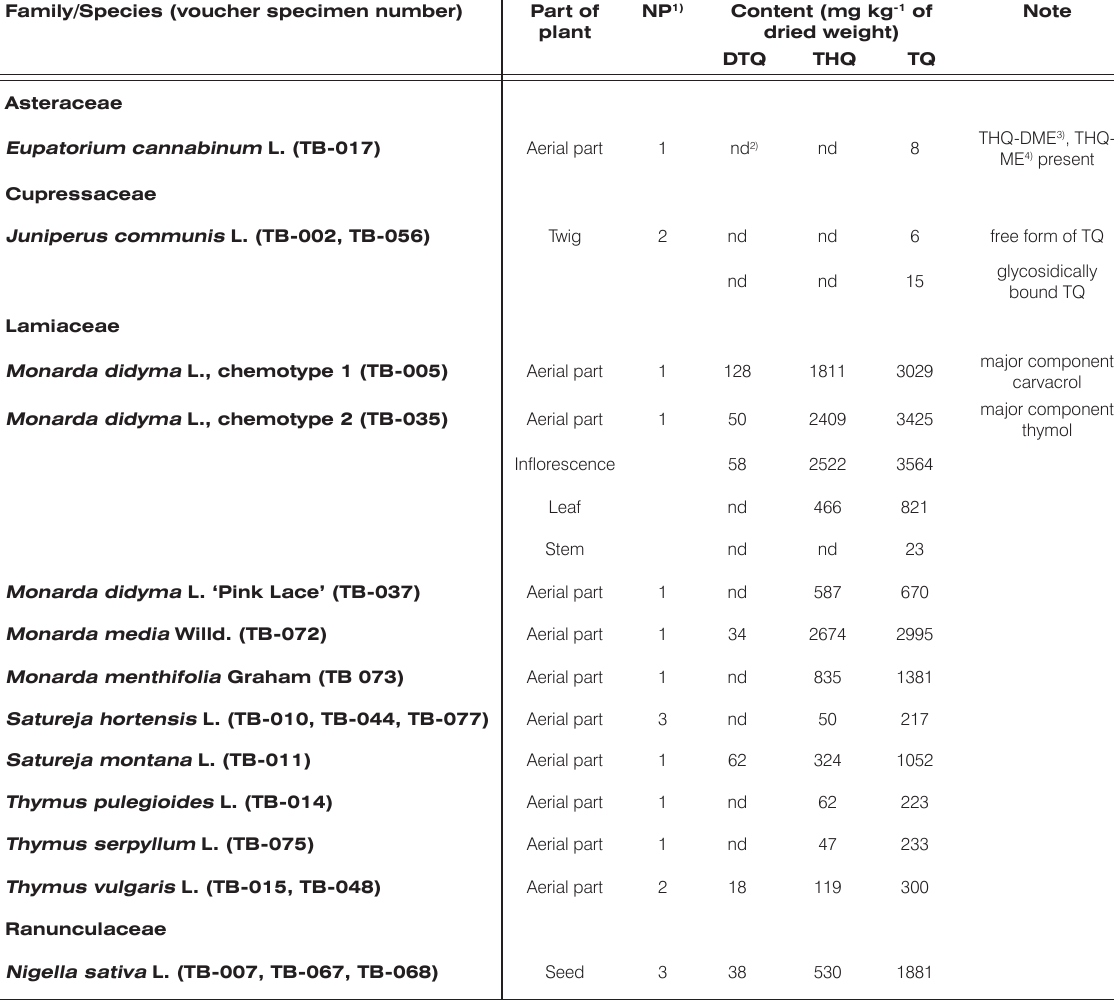
Table 1. Maximum contents of dithymoquinone (DTQ), thymohydroquinone (THQ) and thymoquinone (TQ) in analysed plant species. Family/Species (voucher specimen